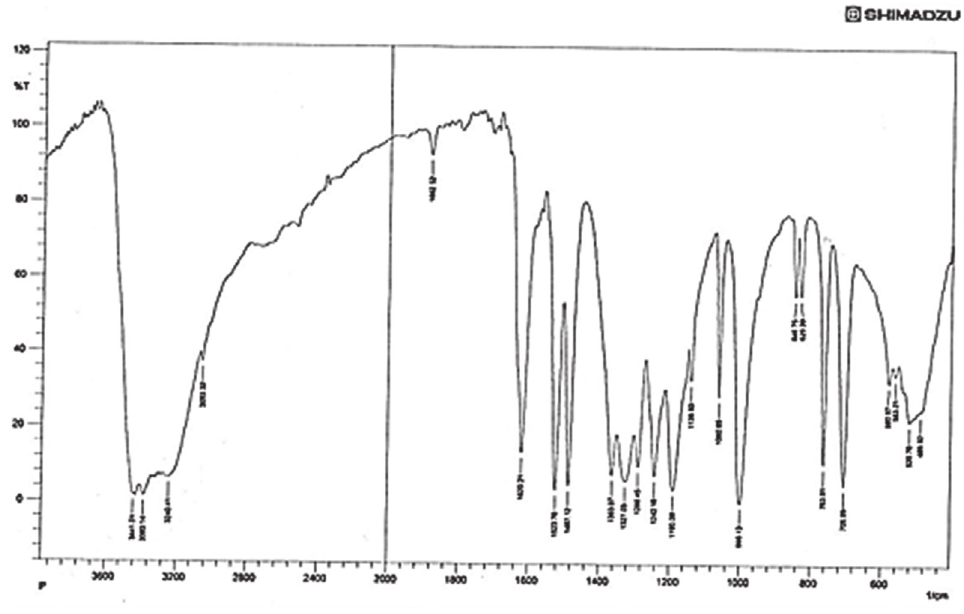
Figure 3: FTIR of pyrogallol.